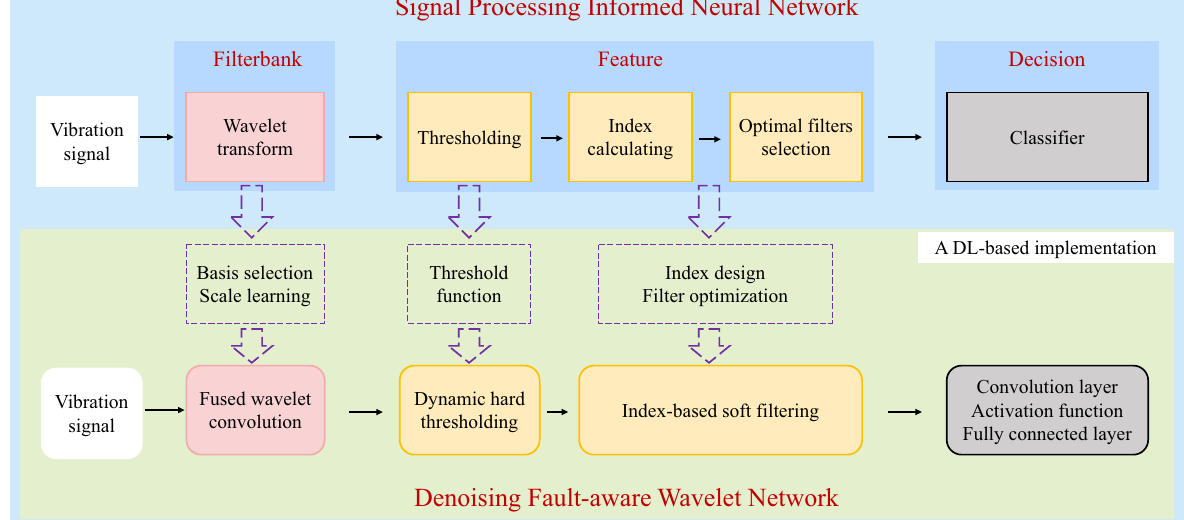
Figure 2 Concrete design of SPINN and its corresponding DL-based implementation: DFAWNet (In the DL-based implementation, we aim to address the problems in the dotted box which are imported by corresponding SP-based methods)